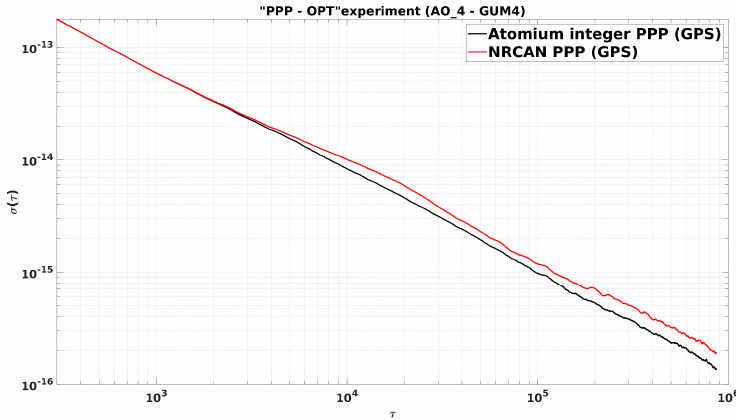
Figure 19. ADEVs between integer PPP and NRCAN PPP results.